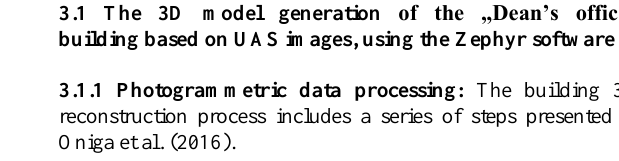
Figure 1. The TLS point cloud with realistic colour information